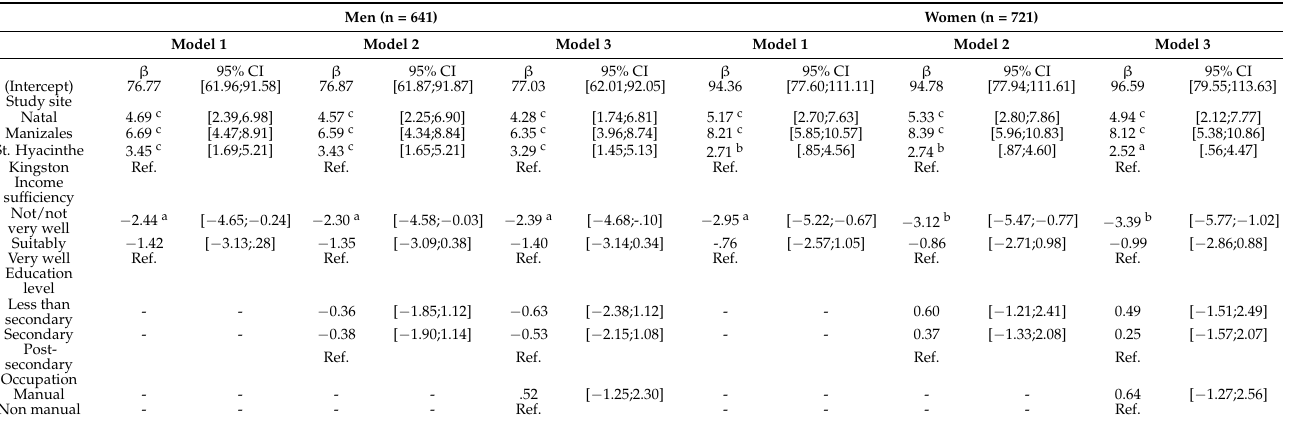
Table 4. Multivariate regression models assessing the influence of socioeconomic variables on the limitation subscale separated by